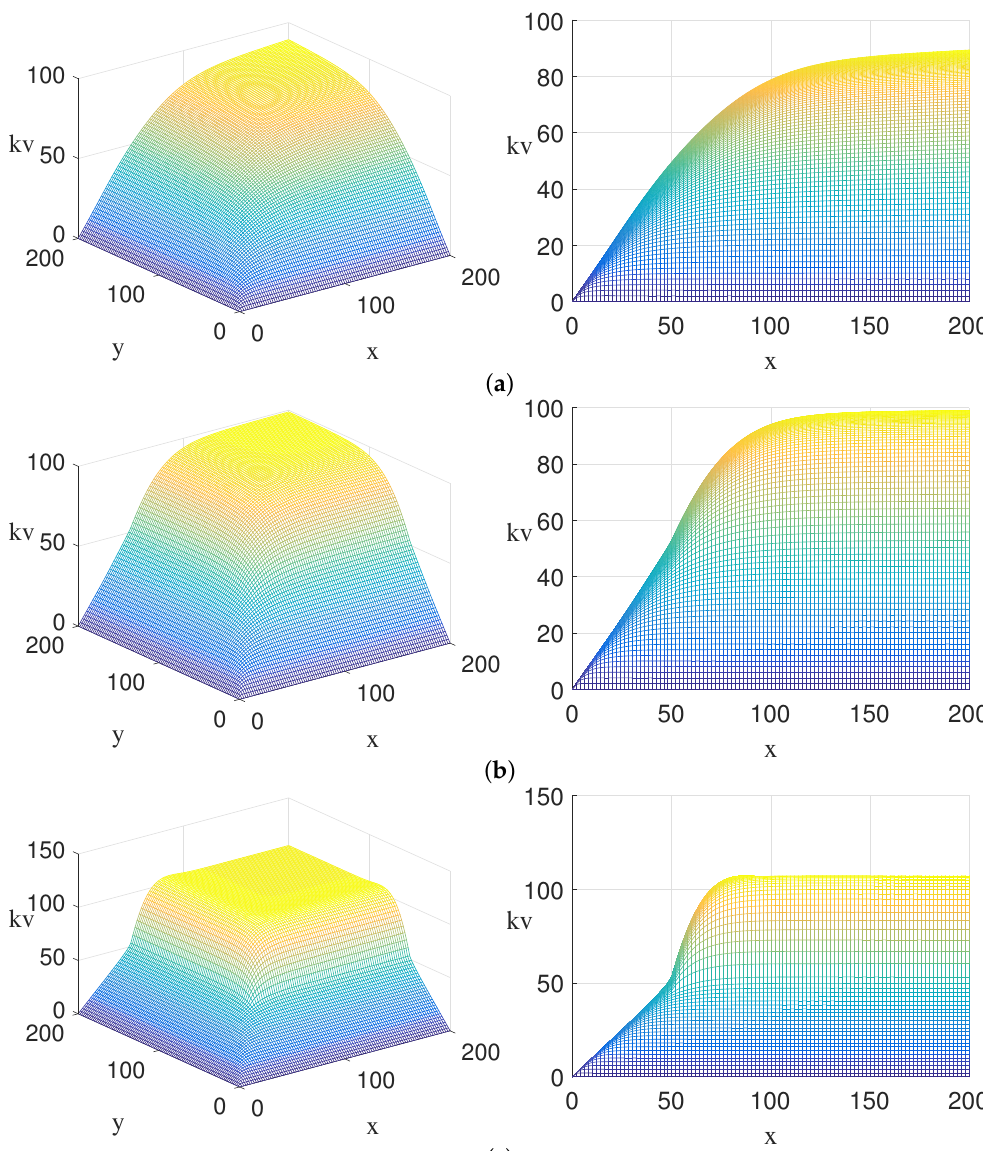
Figure 11. ( a ) denotes kv for different x , y when H x = H y = H z = 0.3 and z = 100, ( b ) denotes kv for different x , y when H x = H y = H z = 0.5 and z = 100 and ( c ) denotes kv for different x , y when H x = H y = H z = 0.7 and z = 100.